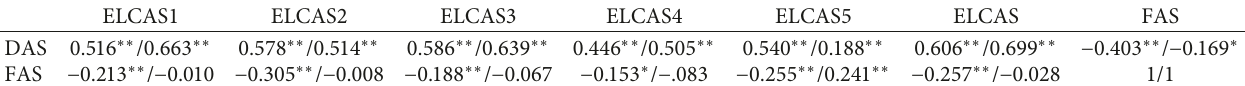
Table 5: Correlations between ELCAS and AAT ( N � 324).